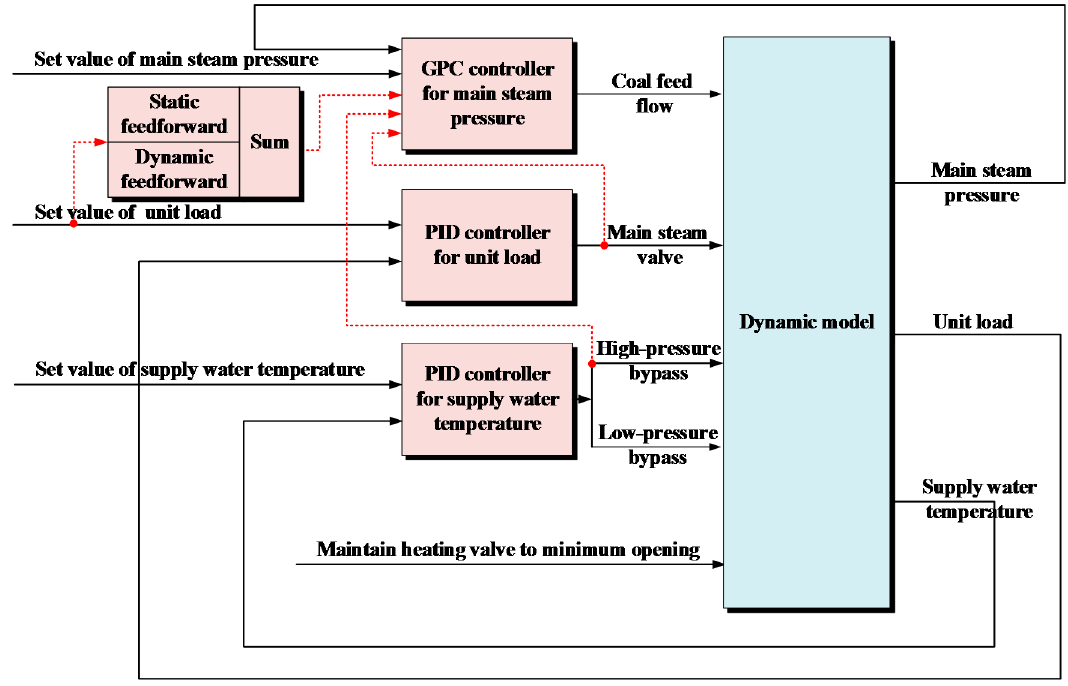
Figure 3. Optimized control scheme for the CHP unit with two-stage bypass.